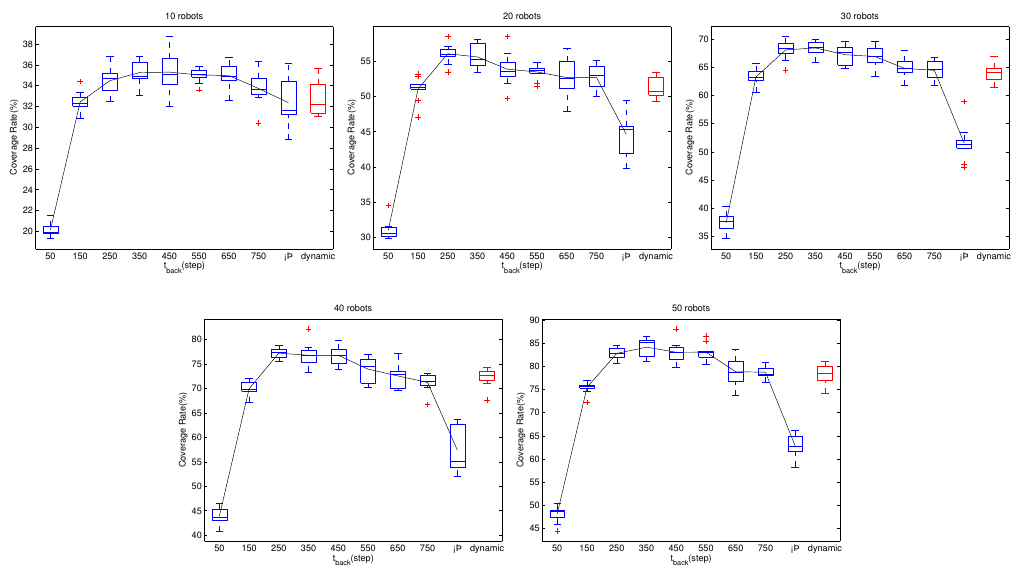
Figure 9. The effects of t back on behavior law f global . Each subfigure illustrates the variation of the swarm’s performance with the increase of t back when using a fixed number of robots. The robot numbers are 10, 20, 30, 40, and 50, respectively. The t back increase from 50 to 150, 250, 350, 450, 550, 650, 750, and ∞ . With ∞ , it means that the robots never visit the communication network. The red box shows the coverage rate with the method in Section 5.2 that adjusts t back automatically. The black line links the mean values of the coverage rate, showing how the performance changes with the increase of t back . Similar to Figure 8, in each subfigure, the black line first increases and then decreases, indicating that, with the increment of t back , the coverage rate will first increase and then decrease. From the five sub-figures, the red box is a bit lower than the top of the black line. This indicates that, with f global , the dynamic adjust t back scheme will provide the performance that is not the best, but still acceptable. Considering that we are unable to get the best t back in advance, using the dynamic adjust t back scheme has application value because it can avoid choosing a poor t back